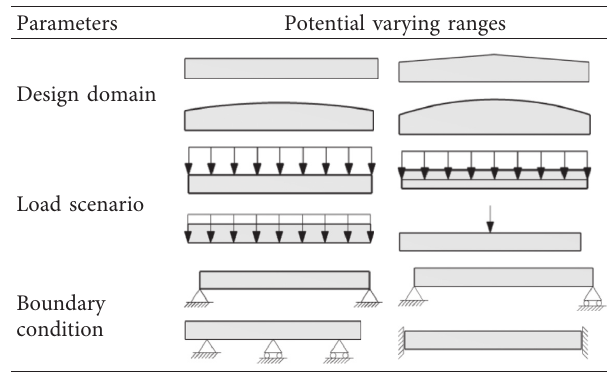
Table 3: Parameters for beam/arch. Table 2: Essential architectural applications